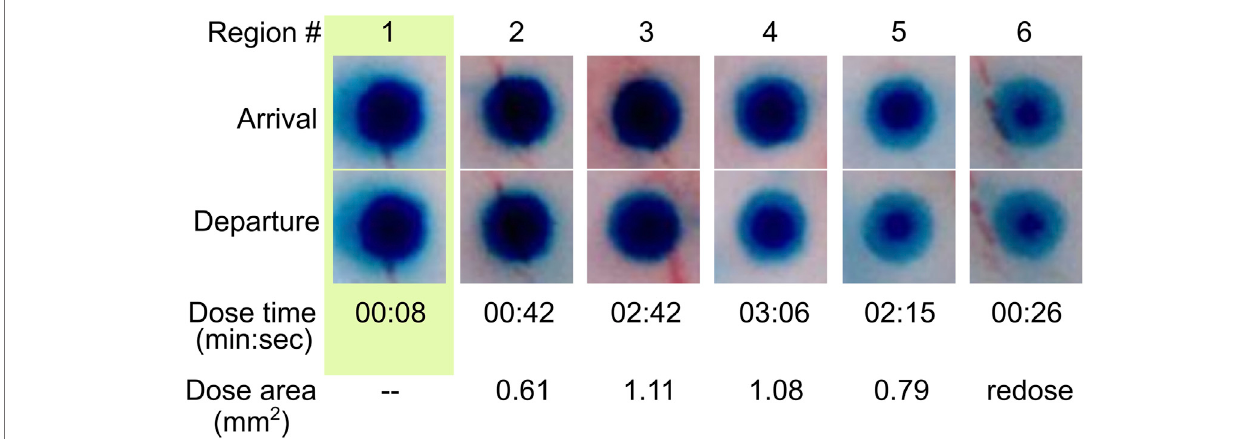
FIGURE 8 | Time lapse release of BG dye from MANiAC. BG distribution in MANiACs before and after dosing six regions (labeled in top row). Optical images of MANiACs upon arrival at and departure from target regions 1 – 6. Shown is a MANiAC sitting on top of tissue releasing the BG at the six different dose sites, with a decreasingcircumferentialintensityastheBGisreleasedfromtheperimeterofthecapsule.ThearrivalrowshowstheMANiAC ’ scoloruponarrivingatthedosesite,and the departure row shows MANiAC ’ s color just before the MANiAC leaves the dose site. Due to burst effect dynamics, the core of the MANiAC maintains high concentrationsofBGafterseveraldosesand severalminutesofBGrelease. BGdepletionfromtheperiphery oftheMANiAC isoptically evidentbydosenumber4.Time is in units of min:sec. Dose area is given as square millimeters.